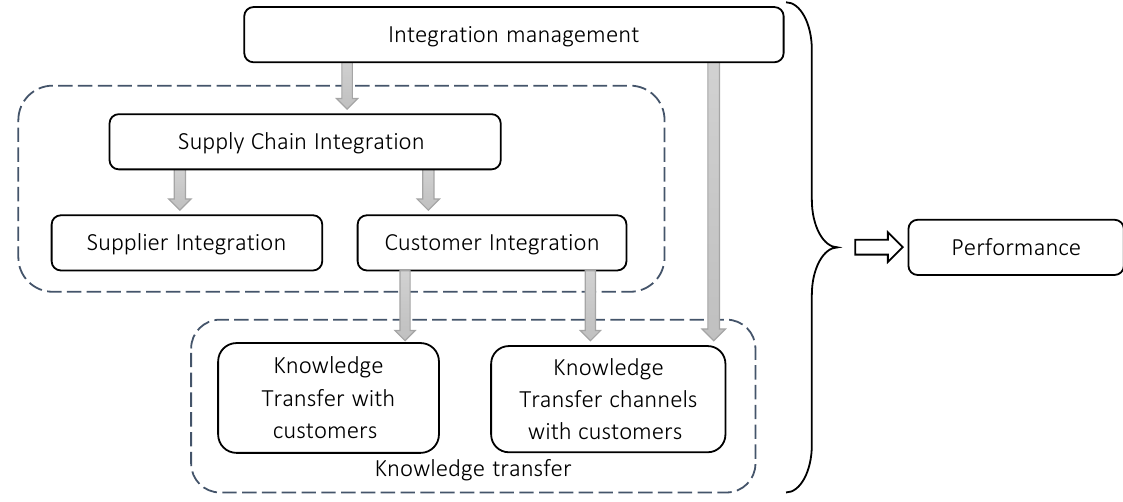
Figure 1. Research